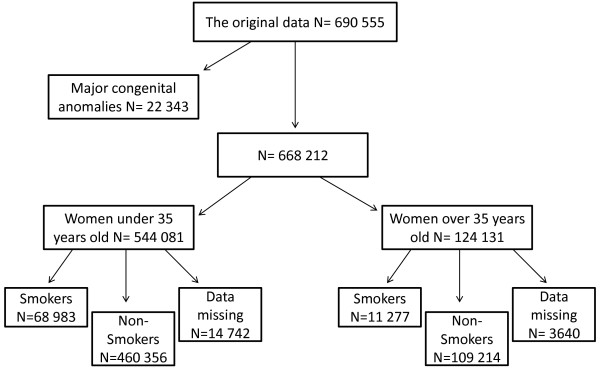
Data flow in the current study.